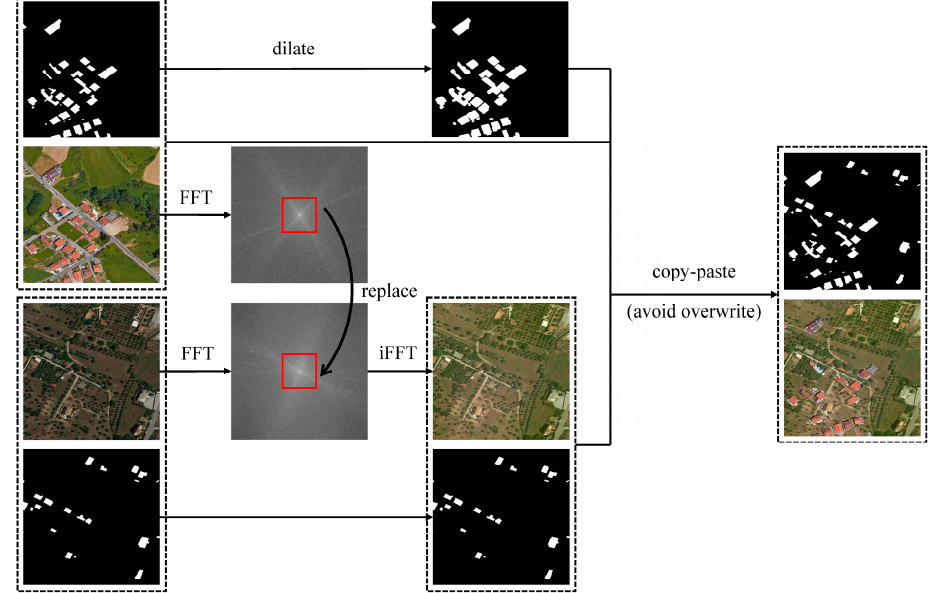
Figure 4. Operation flow chart of cSE, sSE and scSE.